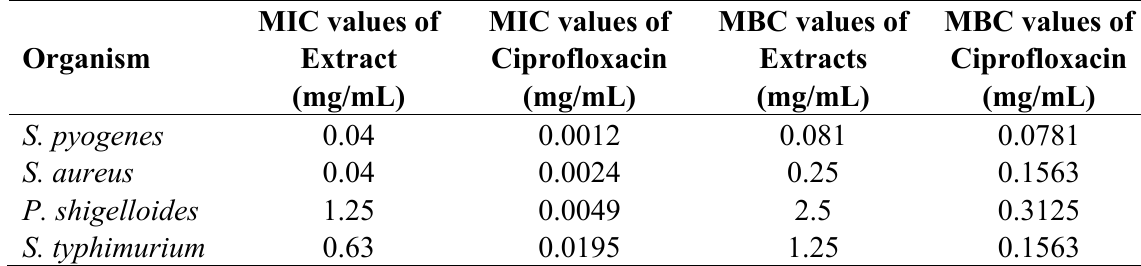
and Minimum Bactericidal 90)